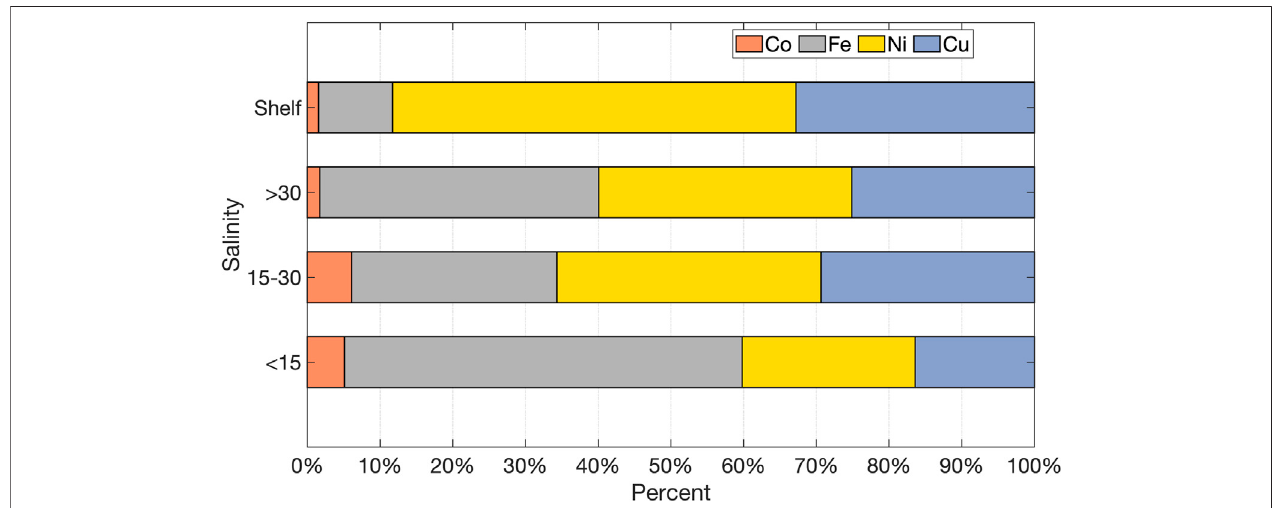
FIGURE7| RelativeabundancesofdCo,dFe,dNi,anddCuasapercentofthesumofall4element ’ sconcentration.Datafromglacierfjordsandcoastalregionsis binnedbysalinity. “ Shelf ” datarefersto3areas oftheGreenland shelfsurveyedbyPS100(eastof15 ° W),GEOVIDE,andD354. Note “ shelf ” isnotanexclusivecategory.